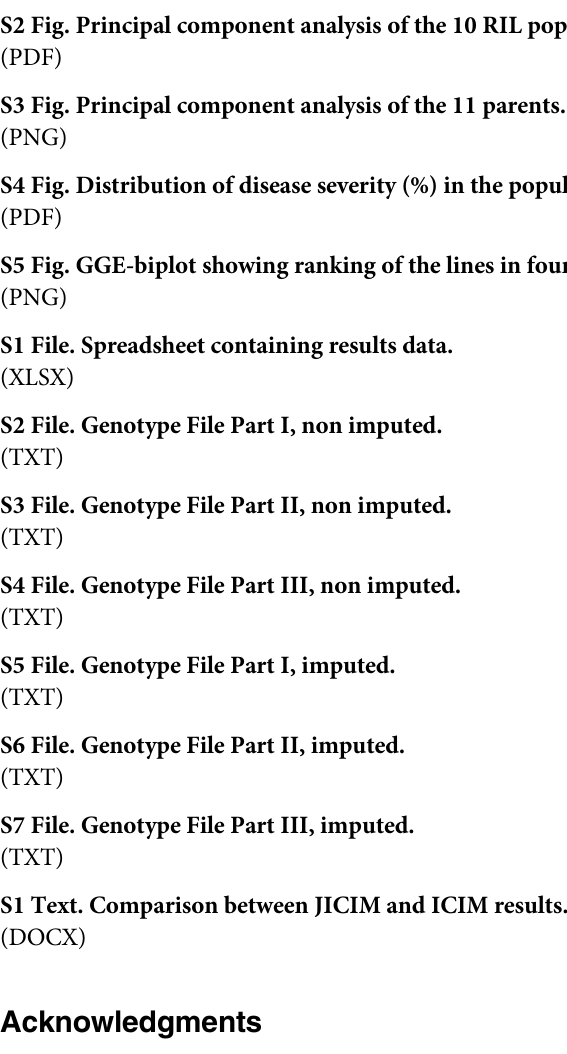
S1 Fig. Schematic workflow of the study. S2 Fig. Principal component analysis of the 10 RIL populations. S3 Fig. Principal component analysis of the 11 parents. S4 Fig. Distribution of disease severity (%) in the populations. S5 Fig. GGE-biplot showing ranking of the lines in four